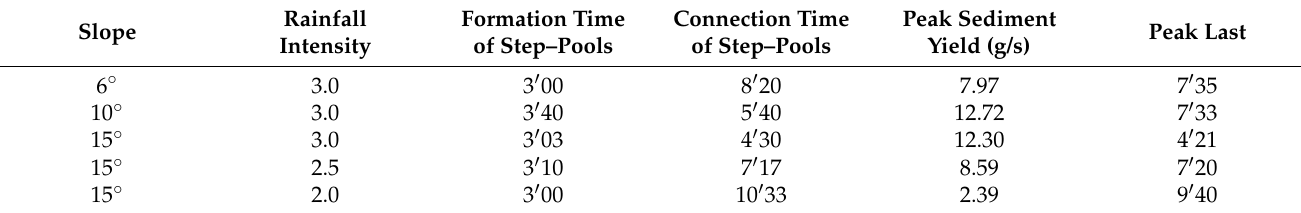
Table 2. Time nodes of rill development and sediment yield